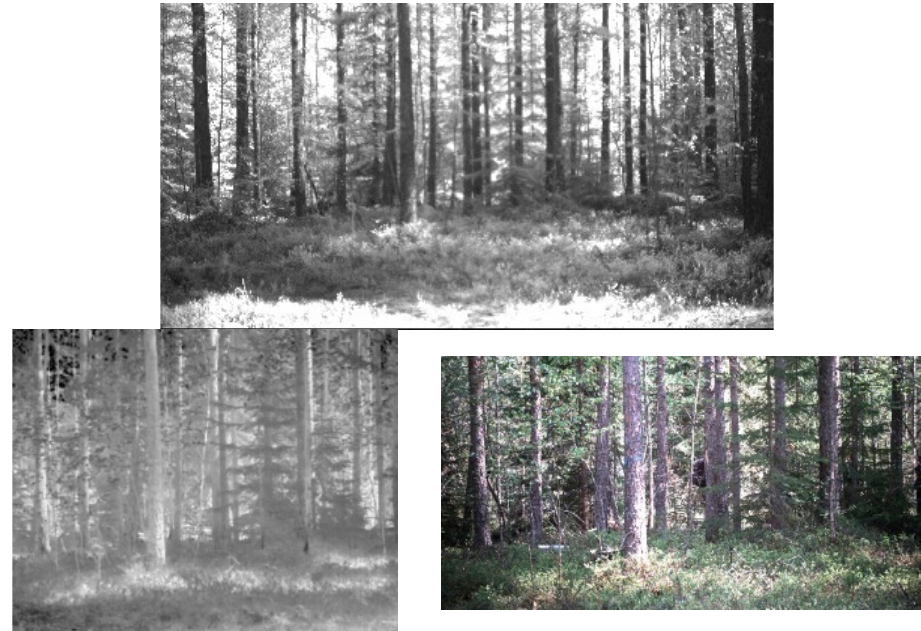
Figure 6. Comparison of the field of view of hyperspectral ( one spectral band ) vs. the thermal ( bottom left ), and RGB ( bottom right ) sensors.